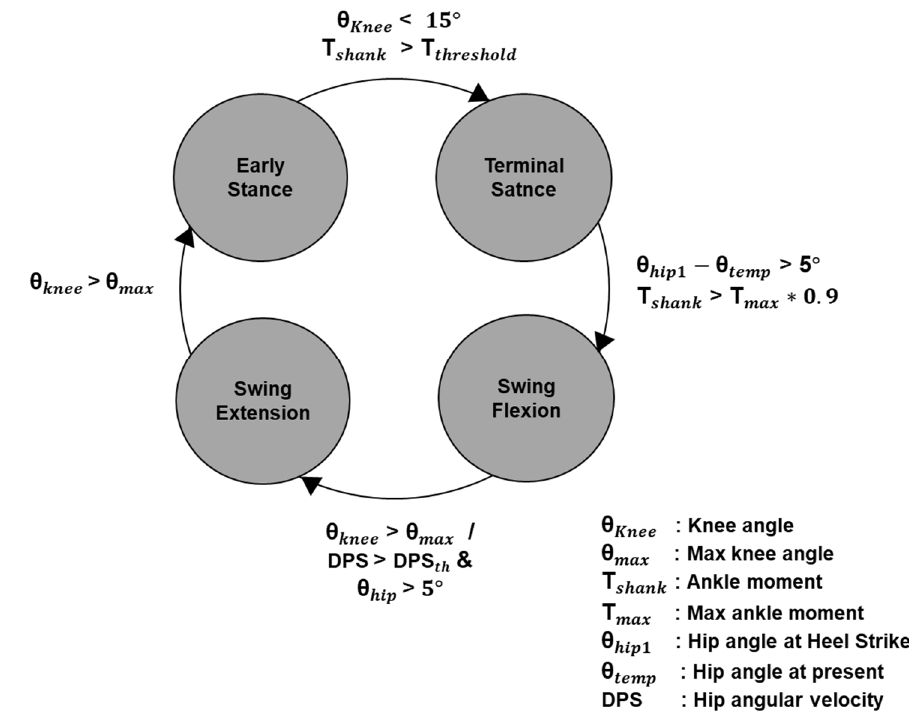
Figure 8. Walking state machine for passive and active walking.